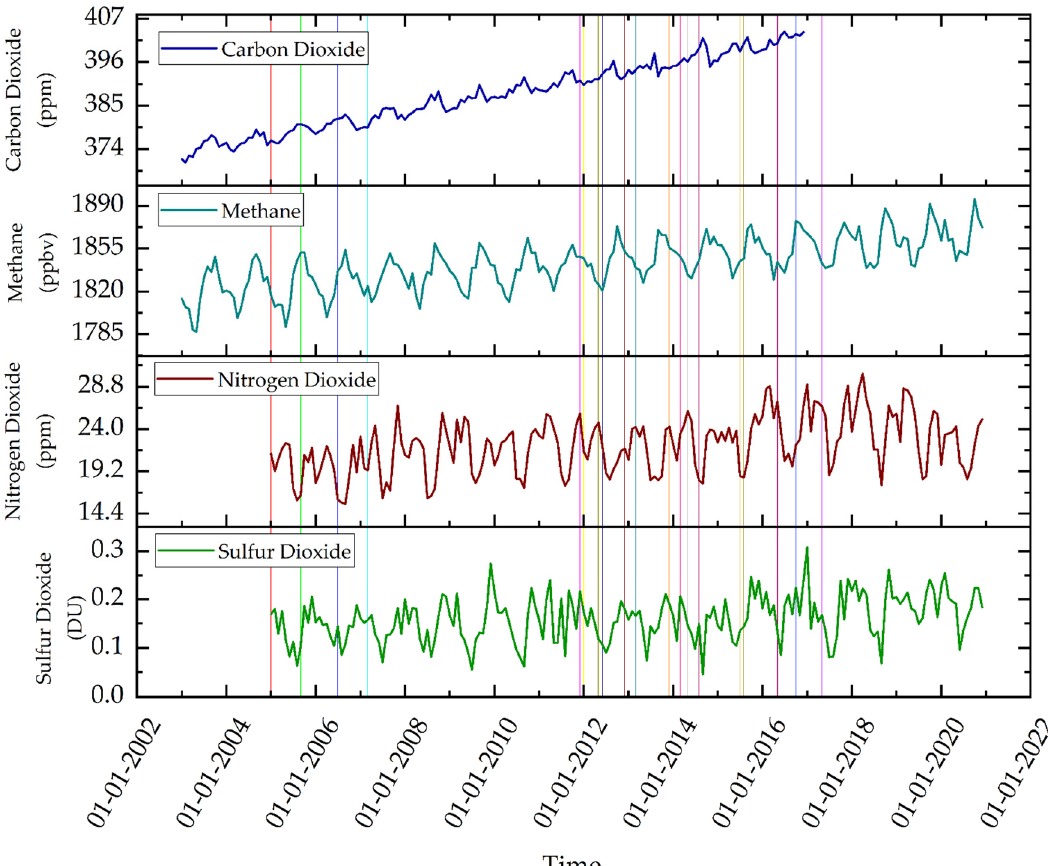
Figure 5. Short-term pollutant variation with respect to TPPs. The straight lines mark the installation of new TPP. Details of new thermal power plants established are as follows: 2 in 2005, 1 TPP in 2006 and 2007, 4 in 2012, 4 in 2013, 4 in 2014, 3 in 2015, 2 in 2016 and 1 in 2017.